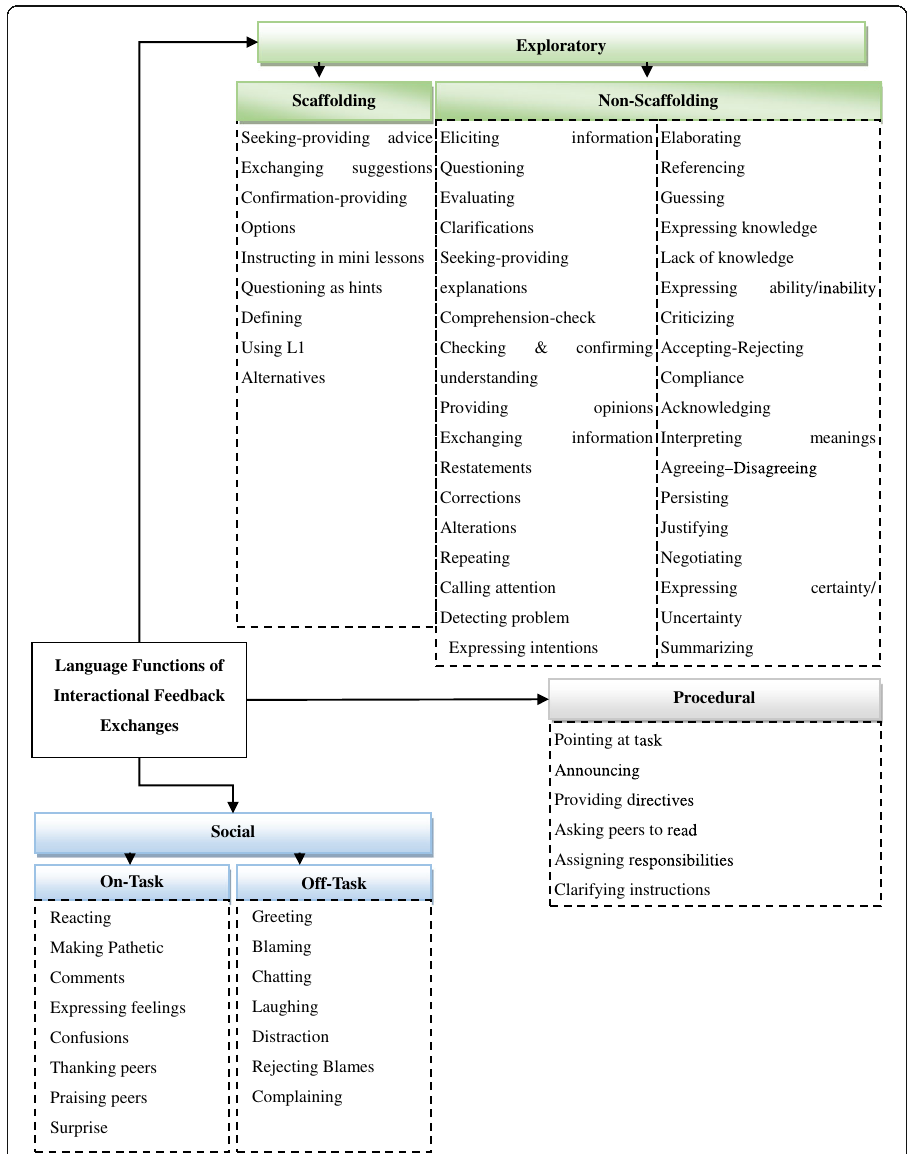
Fig. 1 Patterns of the Language Functions of Learners ’ Interactional Feedback Exchanges in Peer Review.